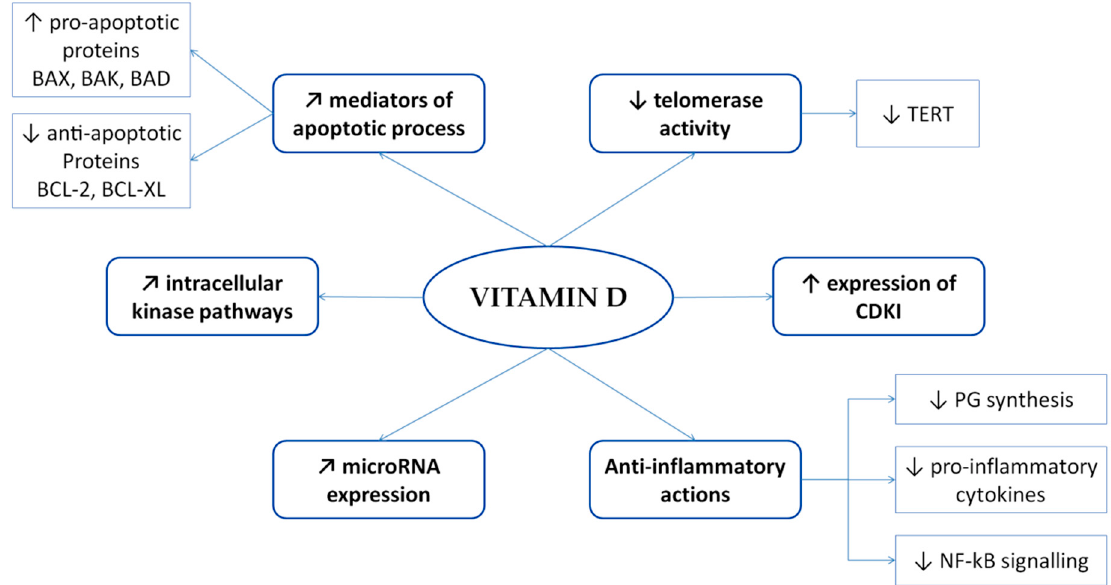
Figure 3. Scheme of the anti-neoplastic and anti-inflammatory role of vitamin D in thyroid tumorigenesis. Arrows illustrates increase ( ↑ ), decrease ( ↓ ), or regulation/modulation ( ↗ ) of specific actions, processes, cells, or molecules. Abbreviations: CDKI, cyclin dependent kinase inhibitors; PG, prostaglandin; TERT, telomerase reverse transcriptase.